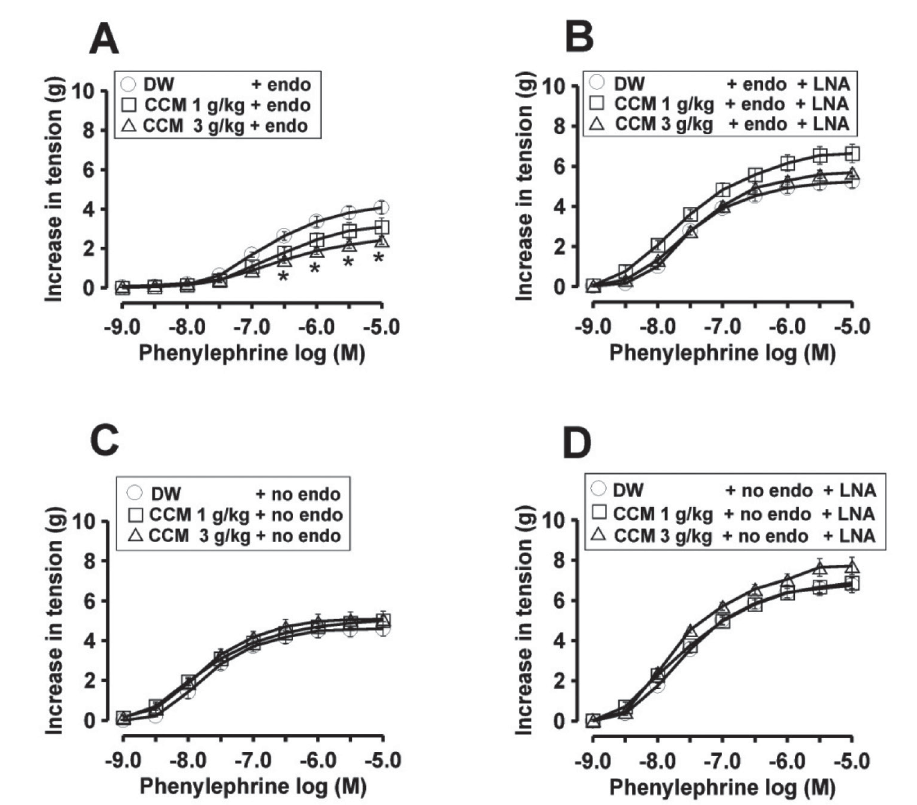
FIGURE 3 - Effects of 6 weeks of oral administration of CCM (1 or 3 g/kg) or distilled water (DW, control) on contractile response to phenylephrine of endothelium-intact (endo, A), endothelium-intact with L-NA (B), without endothelium (no endo, C), or without endothelium with L-NA (D) thoracic aorta. Values represent mean ± SEM; n=6. * Significantly lower than that of the distilled water control group, P < 0.05.